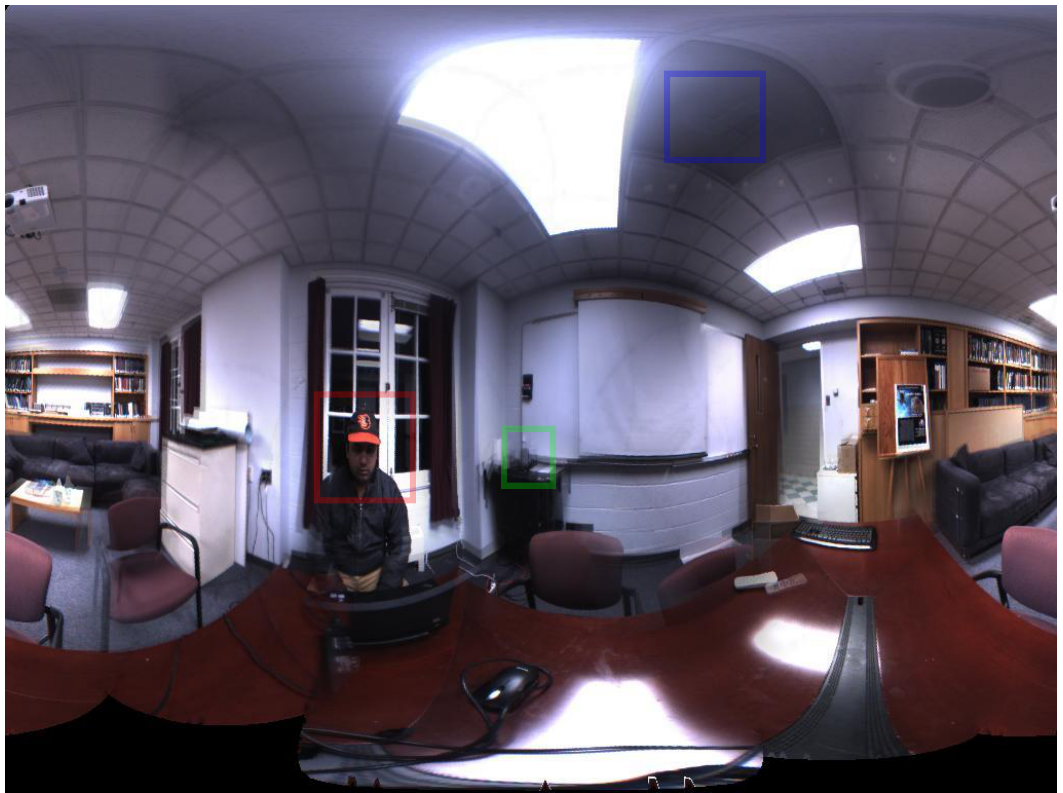
Figure 6. The audiovisual data collection scene. The scene consists of a loudspeaker (green box) and a person and an air conditioning vent (blue